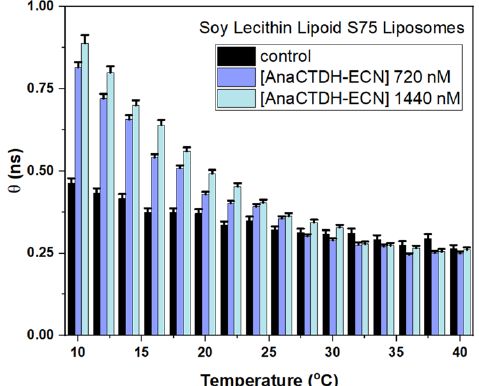
Figure 11. Effect of protein-mediated delivery of carotenoid (echinenone, ECN) using carotenoprotein AnaCTDH on the membrane microviscosity of soy lecithin S75 liposomes revealed by time-resolved fluorescence anisotropy of TM-BODIPY probe at 1 μM concentration. θ is rotational correlation time. Control values were obtained on intact liposomes without carotenoids.